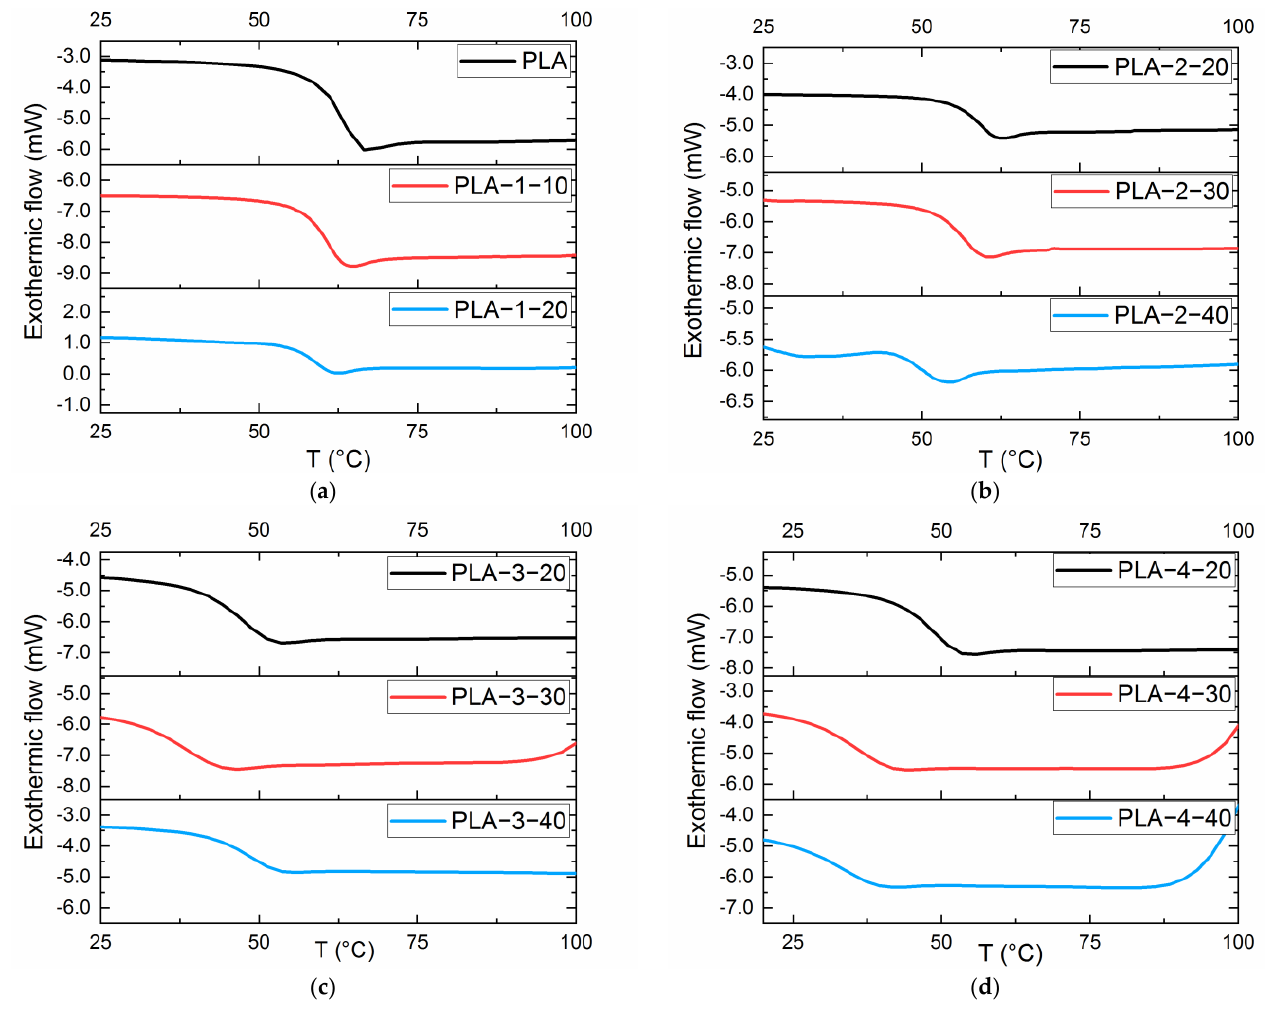
Figure 2. DSC profiles showing the glass transition temperatures evaluated as the inflection point during the second heating step ( a ) for pristine PLA and mixtures PLA − 1 − 10 and PLA − 1 − 20 with 10 and 20% w / w of cutin monomer 1 in the blending with PLA ; and ( b – d ) for mixtures PLA − X − Y where X stands for the molecule ( 2 – 4 ) employed and Y for its concentration in the blending with PLA .